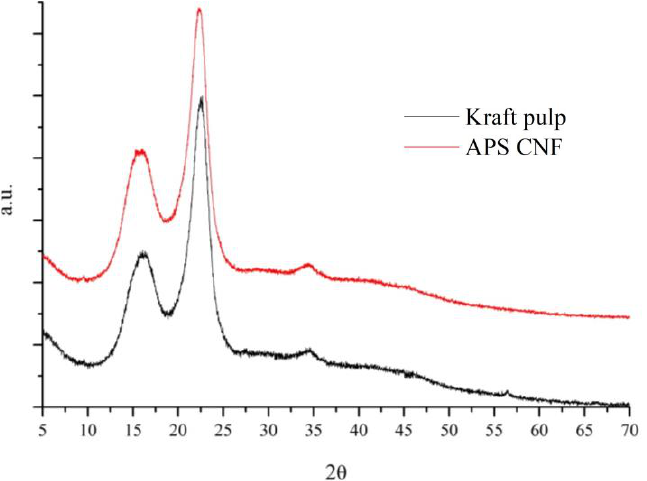
Figure 5. Powder X-ray diffraction spectra of persulfate treated nanofibrillated cellulose (APS CNF) and Kraft pulp.